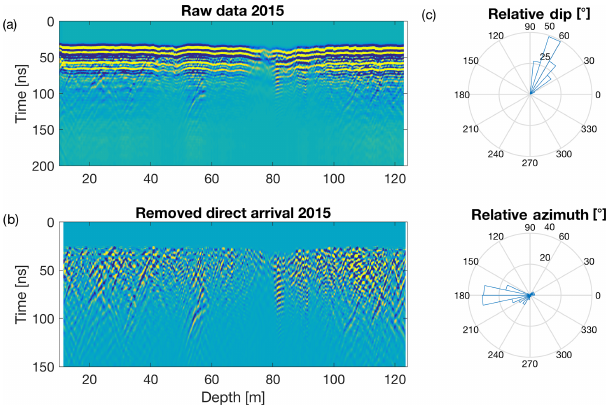
Figure 2. (a) Raw BHR reflection data and (b) after removal of the direct wave and reversed static corrections. (c) Relative dips and azimuths of fractures identified in the OTV